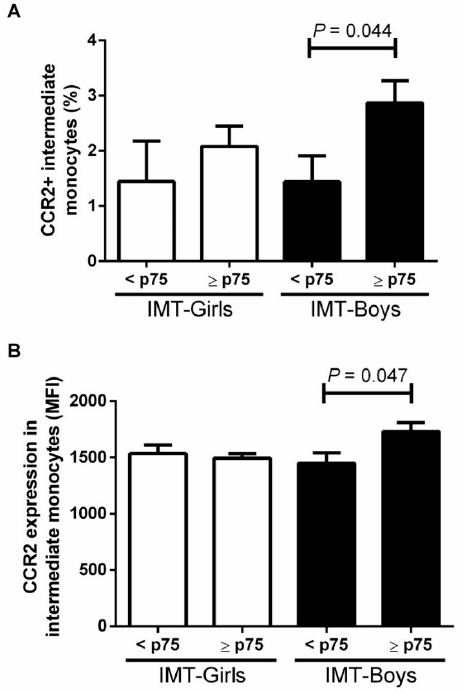
Figure 3. Evaluation of ( A ) the proportion of CCR2 in intermediate monocytes and intima media thickness (IMT) and ( B ) expression of CCR2 in intermediate monocytes and intima media thickness (IMT) by sex. We considered a high-risk IMT ≥ p75 and compared differences by the student T-test, considering a p value < 0.05 as significant. The proportion of nonclassical monocyte expressing CCR2 was 92.3± 80.1% higher in male children with IMT ≥ p75 than in those without a high-risk IMT ( p = 0.037) (Figure 4). Moreover, the CCR2 MFI was 23.1 ± 8.4% higher in nonclassical monocytes from male children with high cardiovascular risk than in males with normal IMT ( p = 0.020) (Figure 4). We found no differences in obese girls with IMT below the p75.